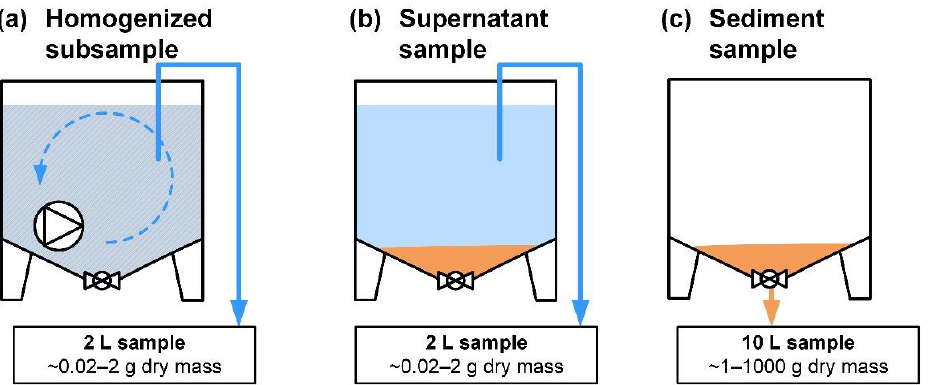
Figure 2. Methods for subsampling from large-volume composite samples.